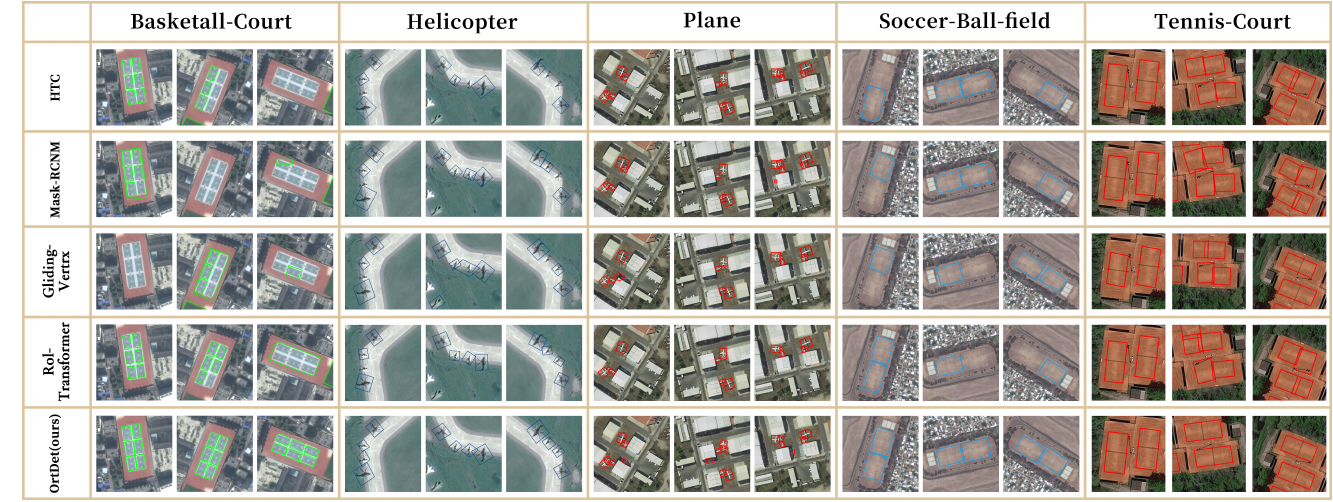
Figure 12. Qualitative comparison with baseline methods in detecting the identical objects categories of different orientations in the DOTA-v1.5 dataset by rotating an input image with different angles. The bounding box is the result of the detection for different categories. The OrtDet architecture is subject to much smaller angular images of the object than the baseline.